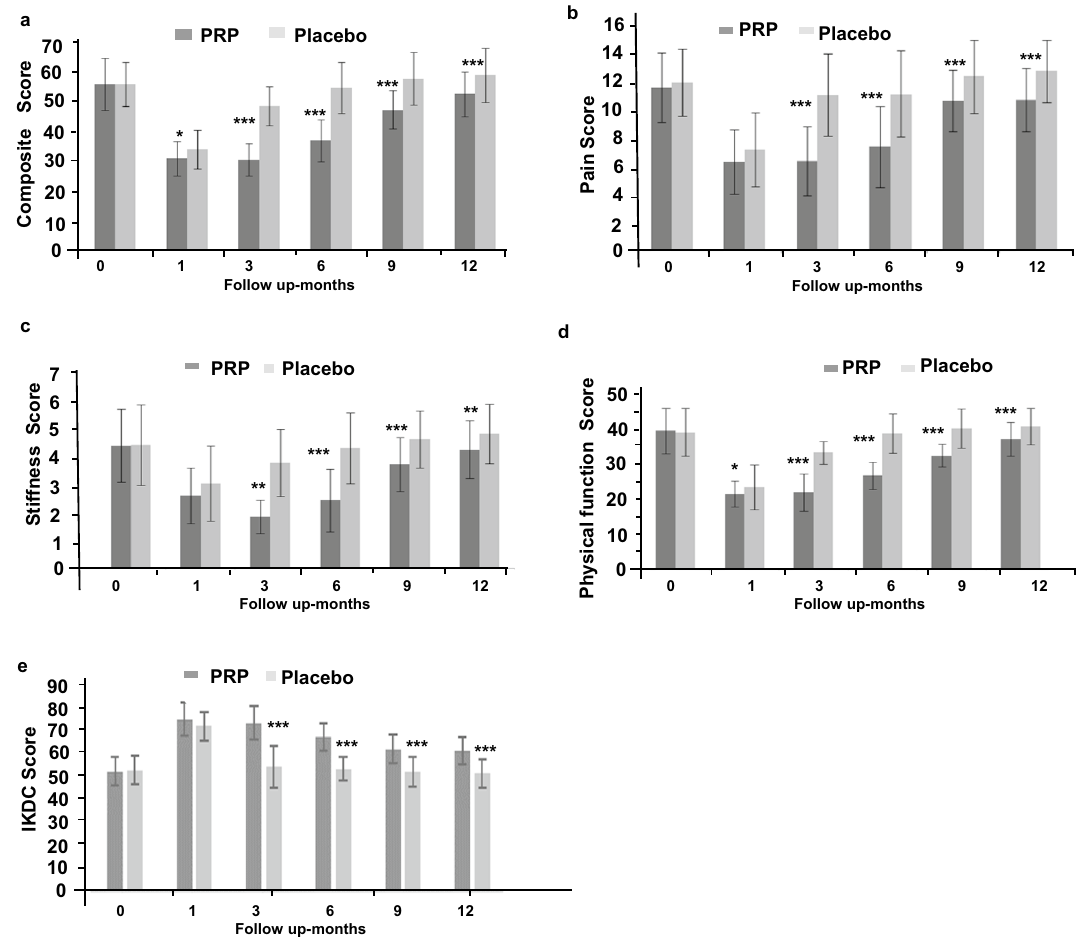
Figure 2. Graphical representation of Western Ontario and McMaster Universities Osteoarthritis Index (WOMAC) score of patients in PRP and control groups over 1 Year ( a ) composite scores, ( b ) pain score, ( c ) stiffness score, ( d ) physical function score ( e ) Graphical representation of IKDC